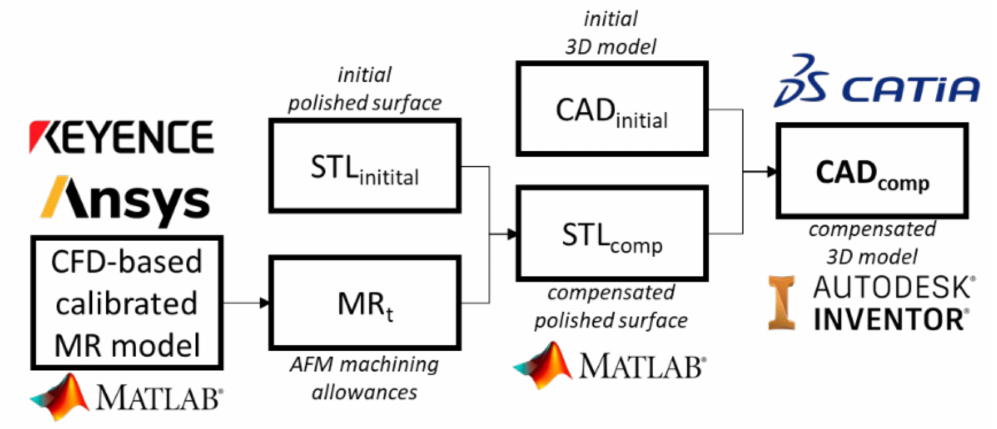
Figure 24. Compensated 3D CAD model